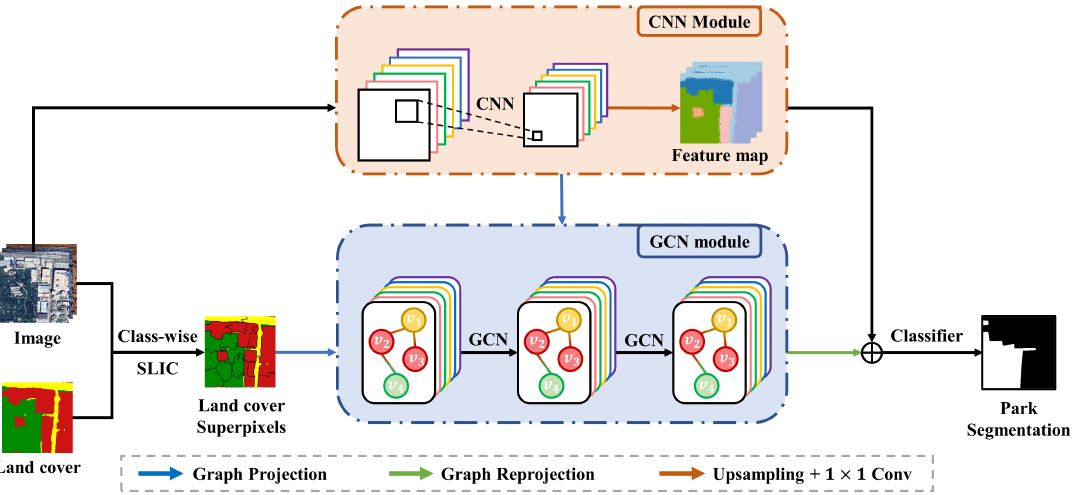
Figure 2. The architecture of CNN-enhanced HEterogeneous Graph Convolutional Network (CHeGCN) model. CHeGCN contains a CNN module and a GCN module, where the former focuses more on a local extraction pattern and the latter concentrates more on long-range dependency modeling. Before the GCN module is applied, the heterogeneous graph needs to be constructed. Nodes in the heterogeneous graph are determined by land cover superpixels and attributed by CNN feature maps. Edges are linked based on topological relations among nodes. Finally, GCN features are reprojected and fused with CNN features to accomplish park